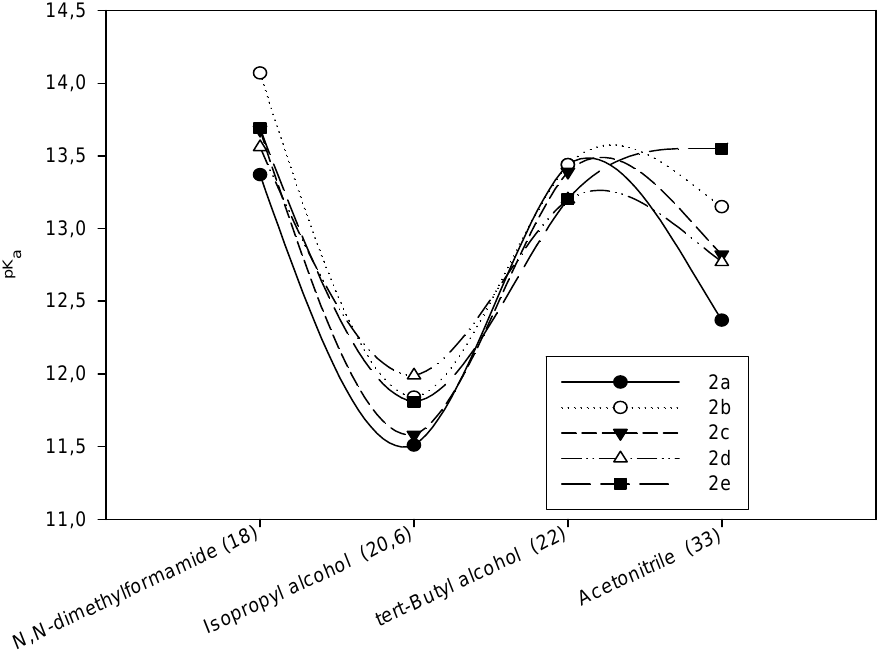
values with autoprotolysis a